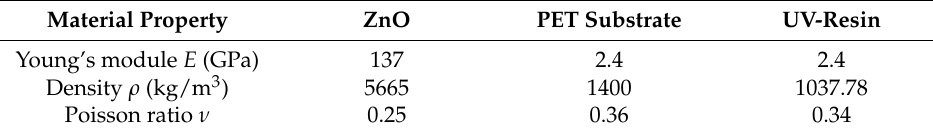
Table 3. Properties of the materials used in the FEM model of the pVEH microdevice